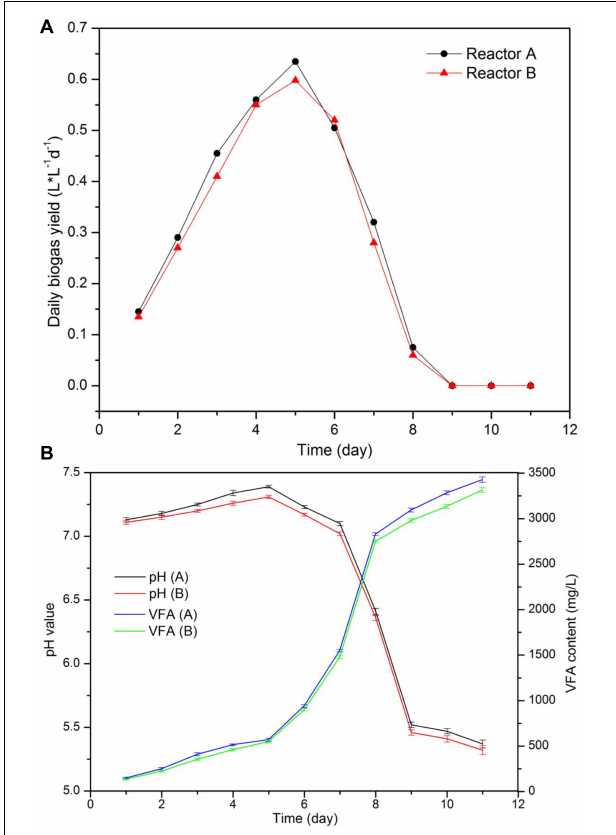
FIGURE 3 | Performance of continuous stirred tank reactors (CSTR) digestion of pork products after HTP: (A) daily biogas production; (B) pH value and VFA content.